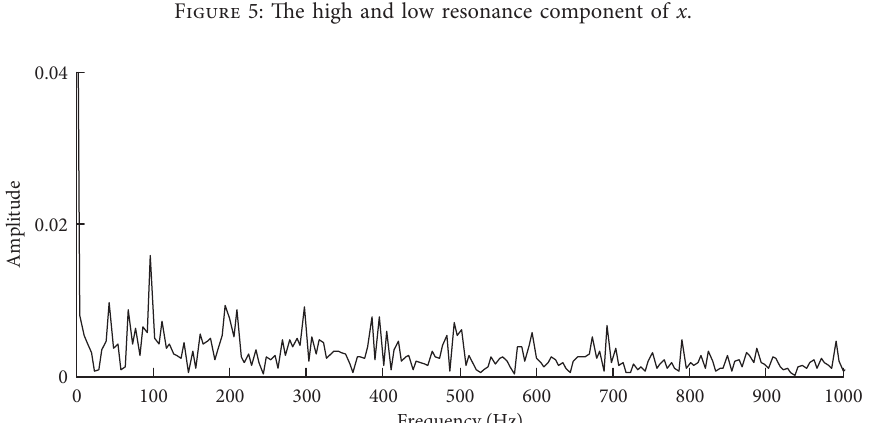
Figure 5: The high and low resonance component of x .